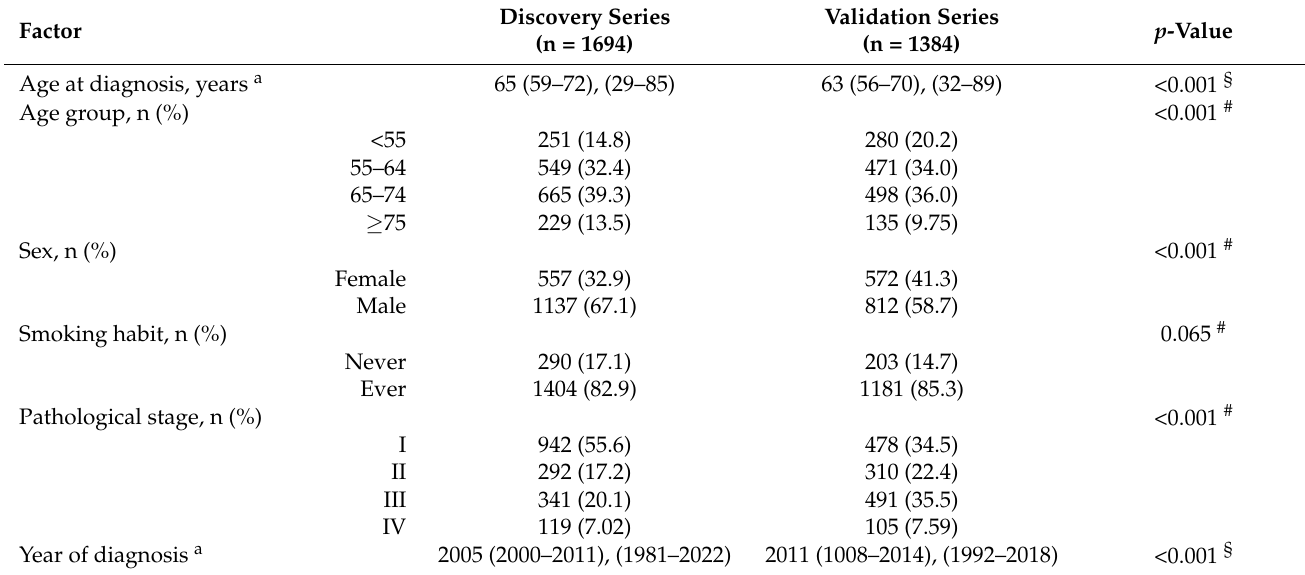
Table 1. Clinical characteristics of lung adenocarcinoma patients in the discovery series and the validation